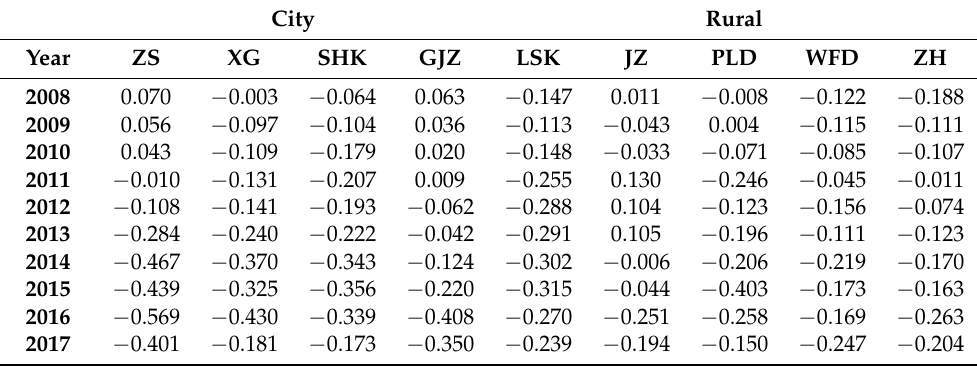
Table 7. Difference between population index and medical and health service index in urban and rural areas